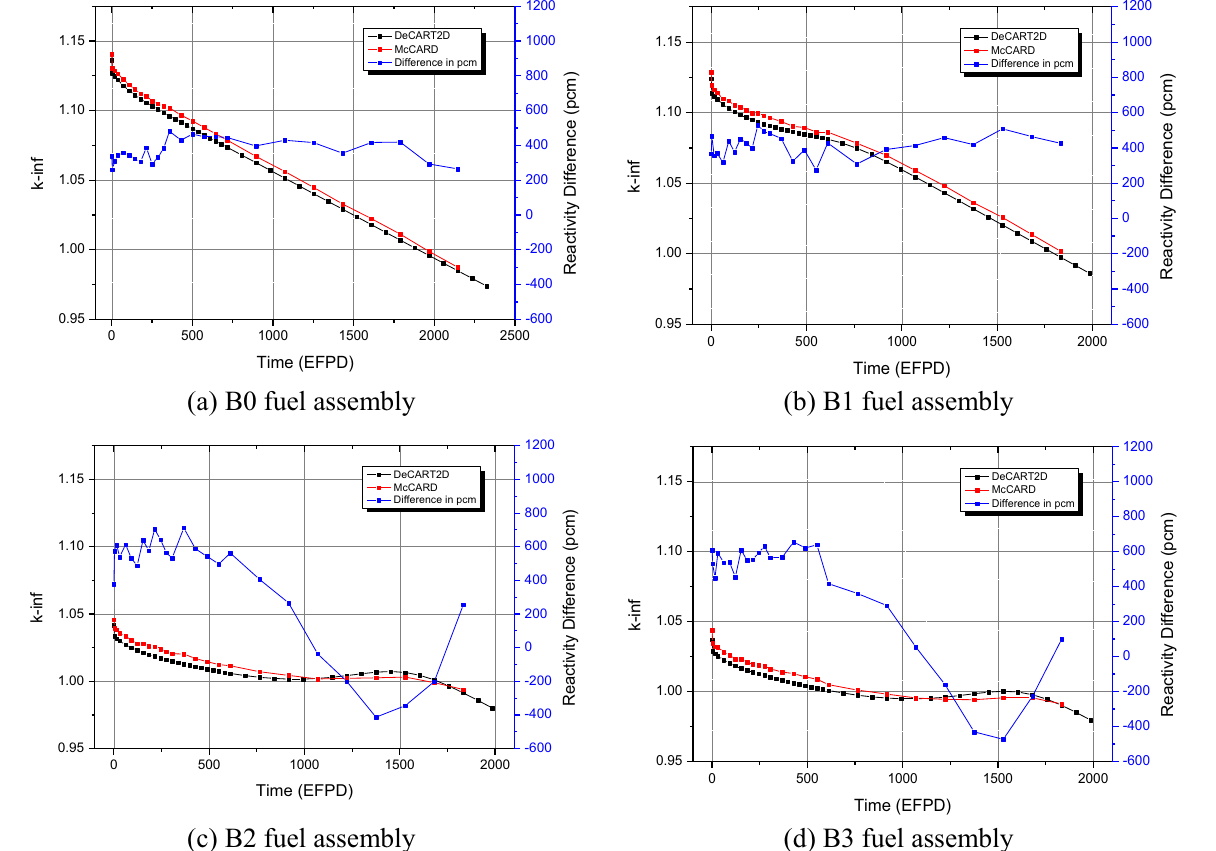
Figure 2. Comparison of the infinite multiplication factors (k assemblies calculated by McCARD and